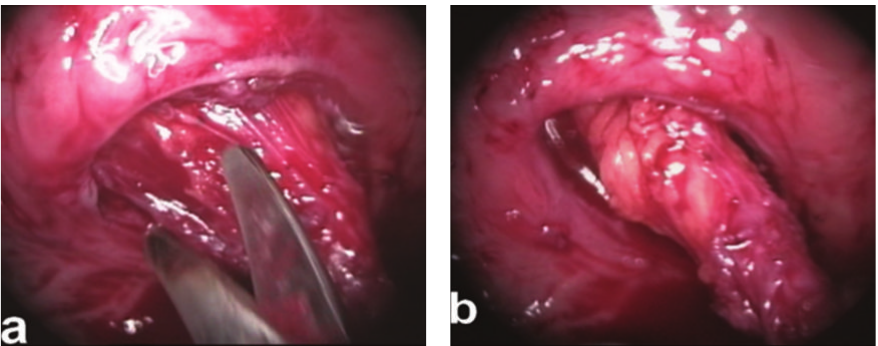
Figure 2: (a), (b) Sharp dissection and progressive mobilization of the distal